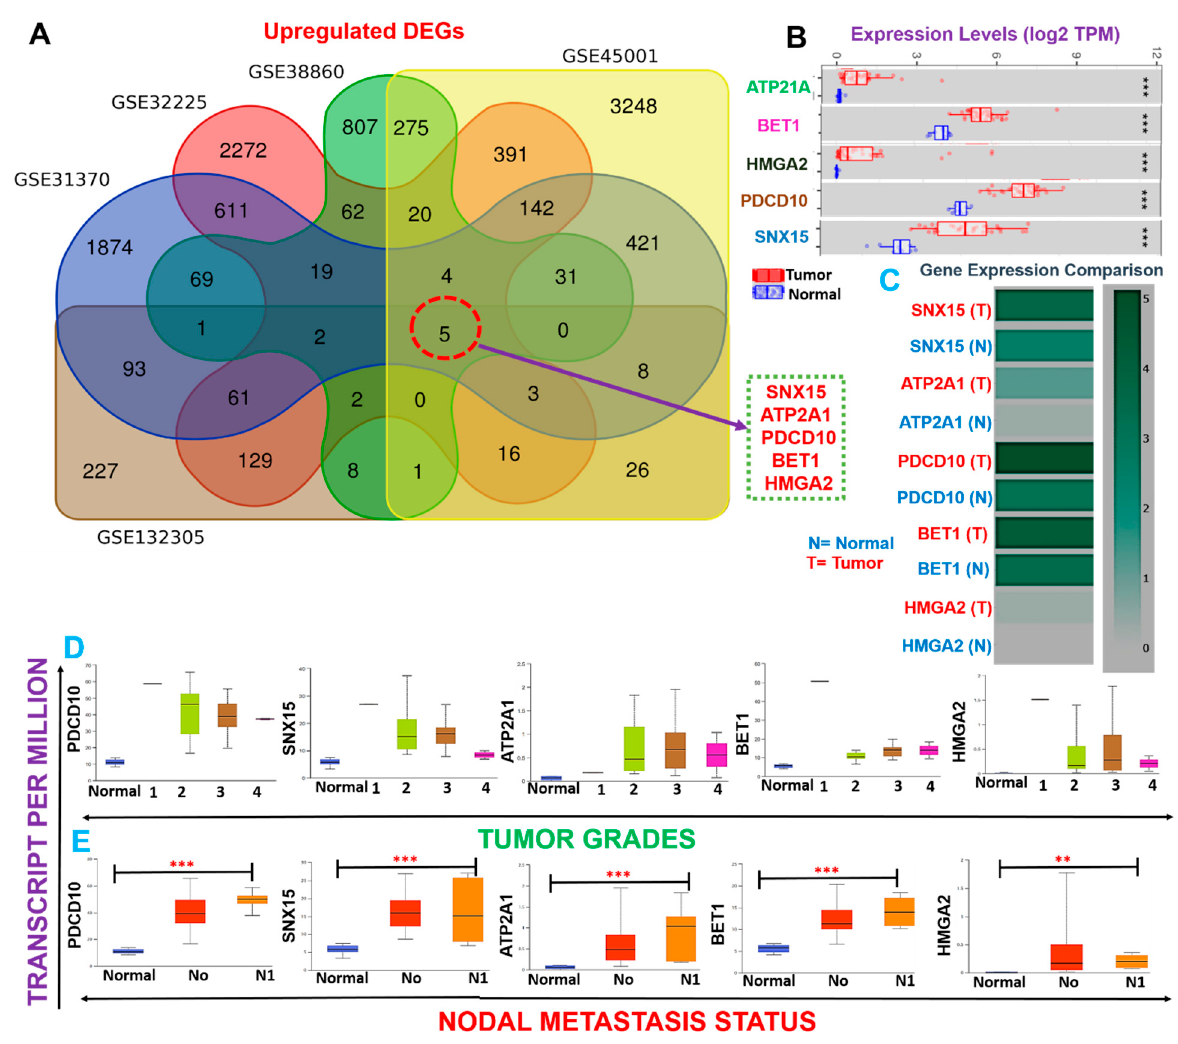
Figure 2. Cholangiocarcinoma (CHOL)-hub genes are biomarkers of tumor progression and metastasis in CHOL patients. ( A ) Venn diagram showing the distribution of differentially expressed genes (DEGs) in each dataset and overlapping upregulated DEGs. ( B ) Boxplot showing differential mRNA expression levels of CHOL-hub genes between TCGA CHOL tumor samples and adjacent normal controls. ( C ) Heatmap of expression difference among CHOL-hub genes. ( D ) Box plot showing differential expression levels of hub genes among tumor grades ( E ) and nodal metastasis statuses in TCGA cohorts of CHOL. ** p < 0.01, *** p < 0.001